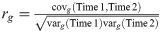
Path diagram of the bivariate twin model applied to longitudinal data assuming additive genetic (A), common environmental (C), and unique environmental (E) components in the variances and covariance of phenotype measurements at time 1 (baseline) and time 2 (follow-up).The genetic correlation is set 1.0 in MZ twin pairs and 0.5 in DZ twin pairs. The shared environmental correlations is set to 1.0 in all twin pairs; rg, rc, re are the genetic, shared environmental and unique environmental correlations on phenotype levels at the two time points, respectively. Hereof rg can be calculated as rg=covg(Time 1,Time 2)varg(Time 1)varg(Time 2), where varg (Time 1), varg (Time 2) are the additive genetic variance of Time 1 and Time 2 respectively, and covg (Time 1,Time 2) is their genetic covariance. Likewise, correlations for common environmental (rc), and unique environmental (re) factors can be calculated.